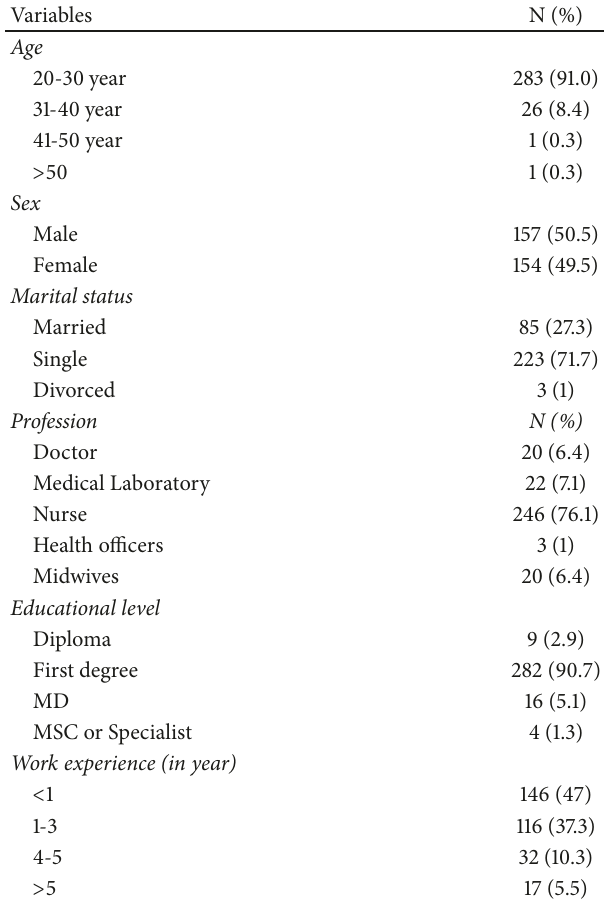
Table 1: Sociodemographic characteristics of HCWs at Hiwot Fana Specialized University Hospital,